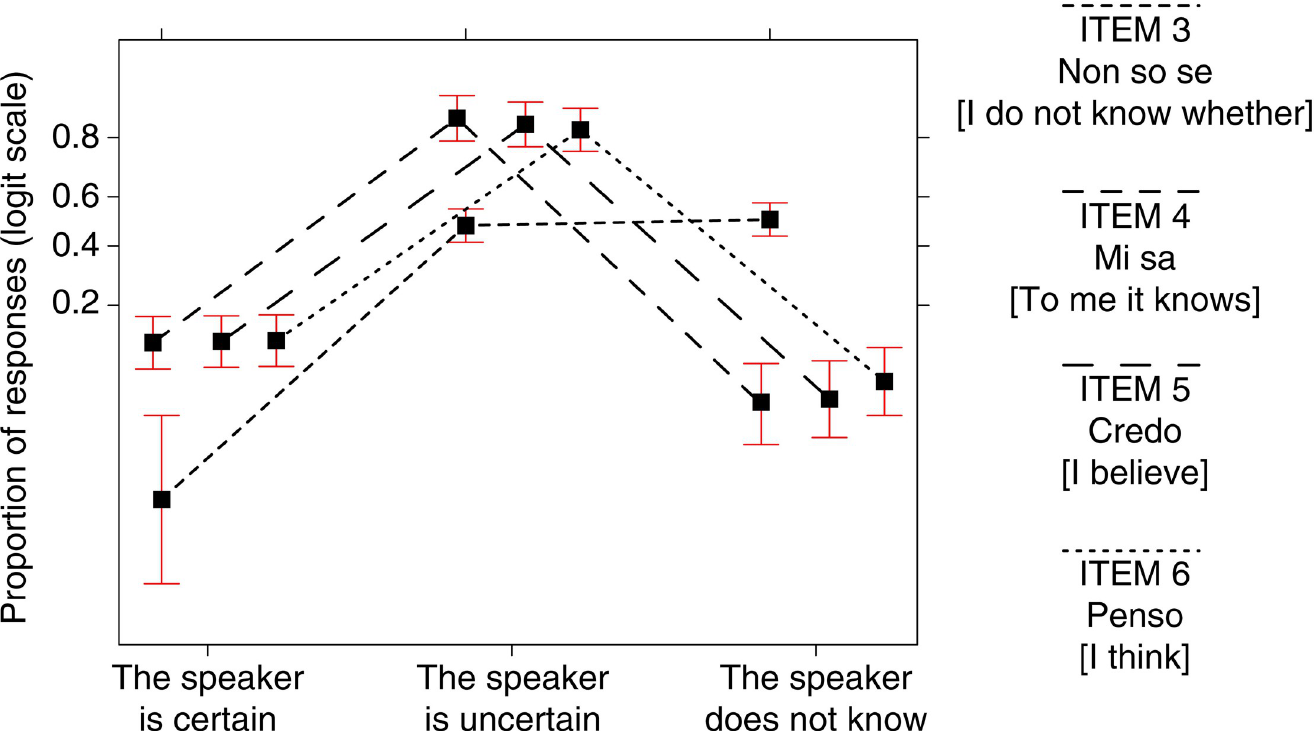
Fig 6. Synoptic view of the proportion of responses for sentences (3), (4), (5), (6) concerning the three EMPs.